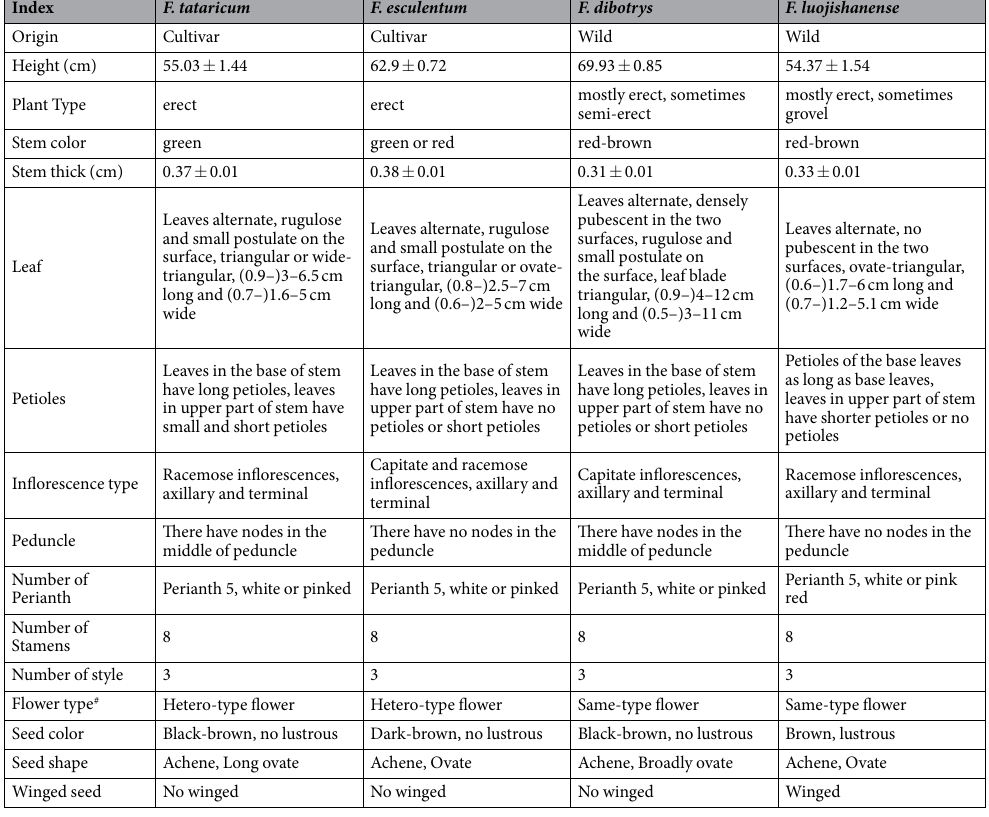
Table 1. Morphological description of four Fagopyrum species. # The same-type flower: Flower has different length of pistil and stamen. The hetero-type flower: The pistil length of flower is equal to